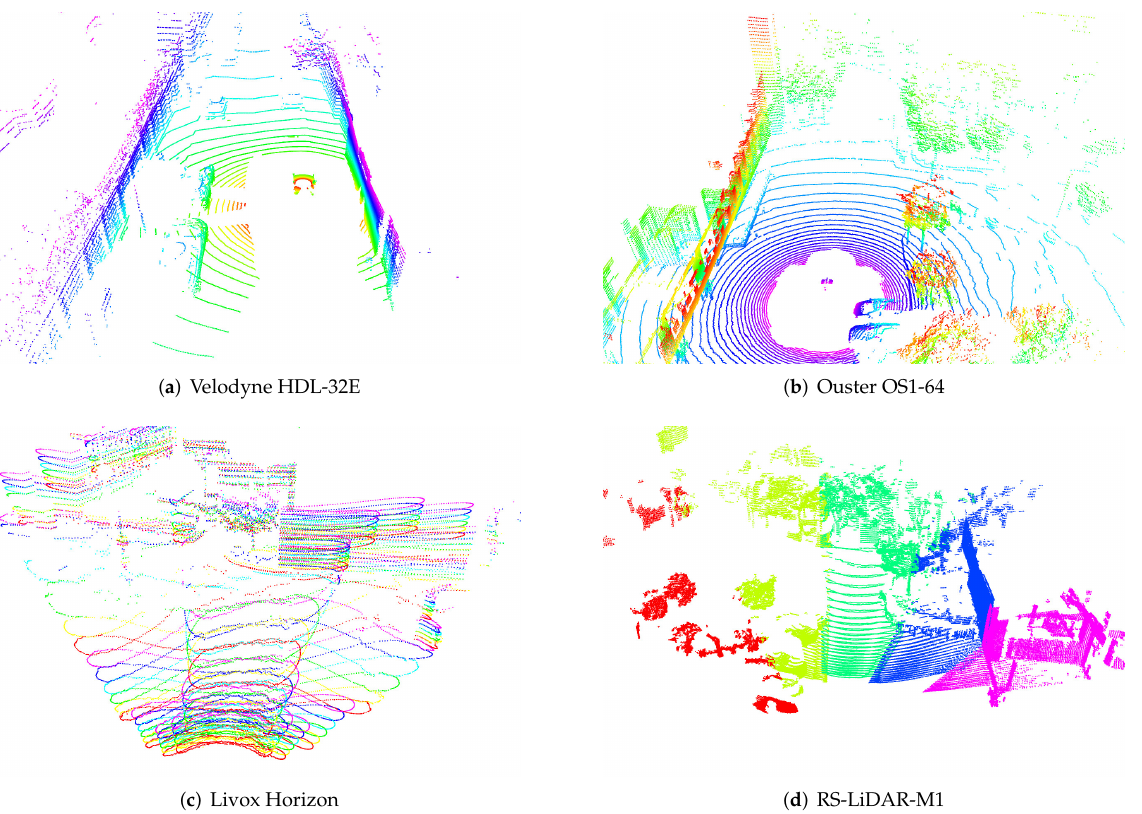
Figure 1. In feature extraction, the scan line structure is used to determine the neighborhood relationship between points. In the above figure, different scan lines are represented by different colors. Different scan lines can be parallel to one another ( a , b ), stacked vertically for irregular motion ( c ), or responsible for different areas ( d ). Due to the variety of structures, it is difficult to uniformly identify neighbors across scan lines. For example, a point on one scan line in Velodyne HDL-32E may be a neighbor of a point with similar timestamps on another scan line; however, this is not the case in